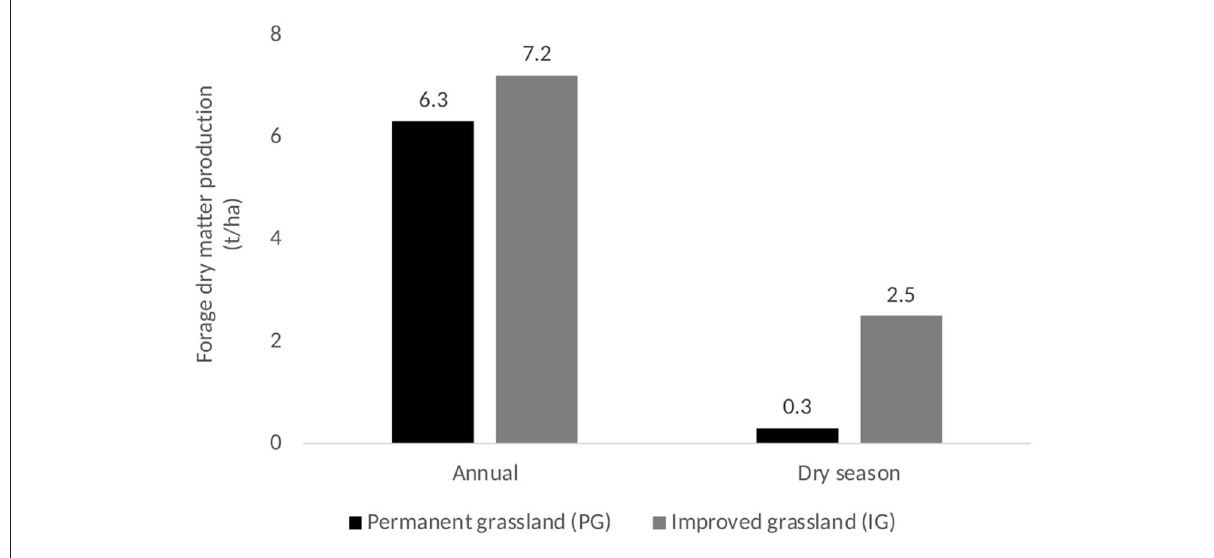
FIGURE4 Forage dry matter (DM) in two grassland areas at Hacienda San Jose,